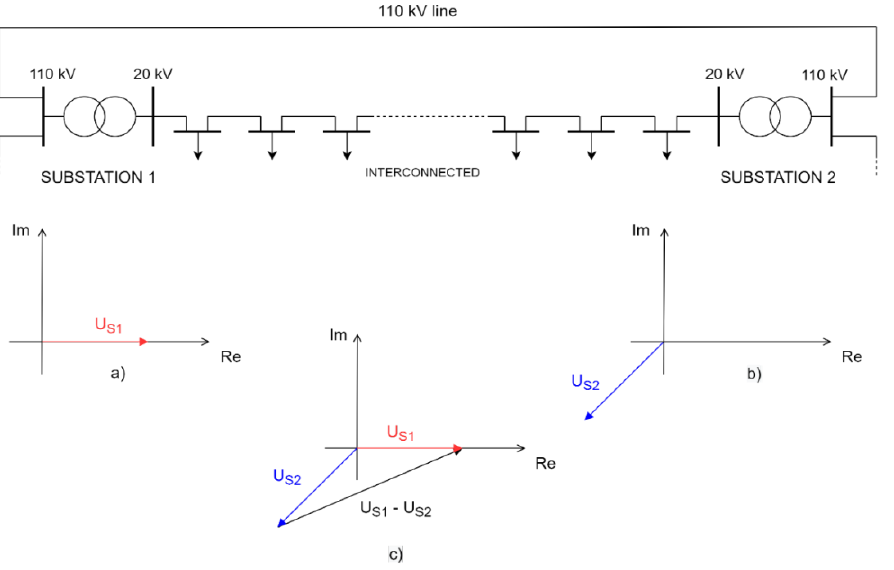
Figure 14. Equalizing current caused by different winding connections of feeding transformers: ( a ) secondary voltage of substation 1, ( b ) secondary voltage of substation 2, and ( c ) voltage difference causing the equalizing current.